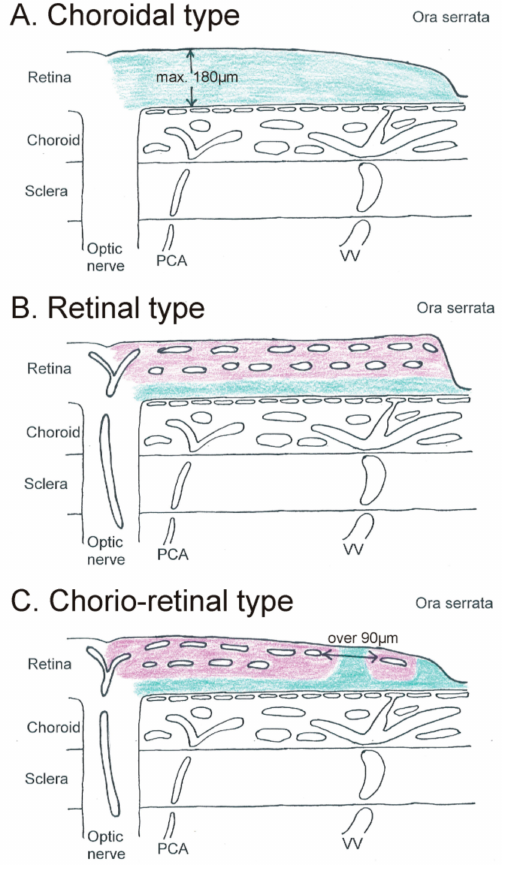
Figure 1. Schematic drawing of a flat-mounted sagittal section through the posterior eye showing the di ff erent vascular supplies for the inner retina (retinal ganglion cells). ( A ). In the choroidal type, the whole retina is supplied by the choriocapillaris (green). ( B ) In the retinal type, two capillary layers in the retina supply the whole inner retina (pink). Only the outer retina is supplied by the choriocapillaris (green). ( C ) In the chorio-retinal type, two retinal capillary layers are only present in the central part. In the periphery, the inner retina is only partly supplied by retinal vessels (pink); other parts are supplied by the choriocapillaris (green). PCA = posterior ciliary artery. VV = vortex